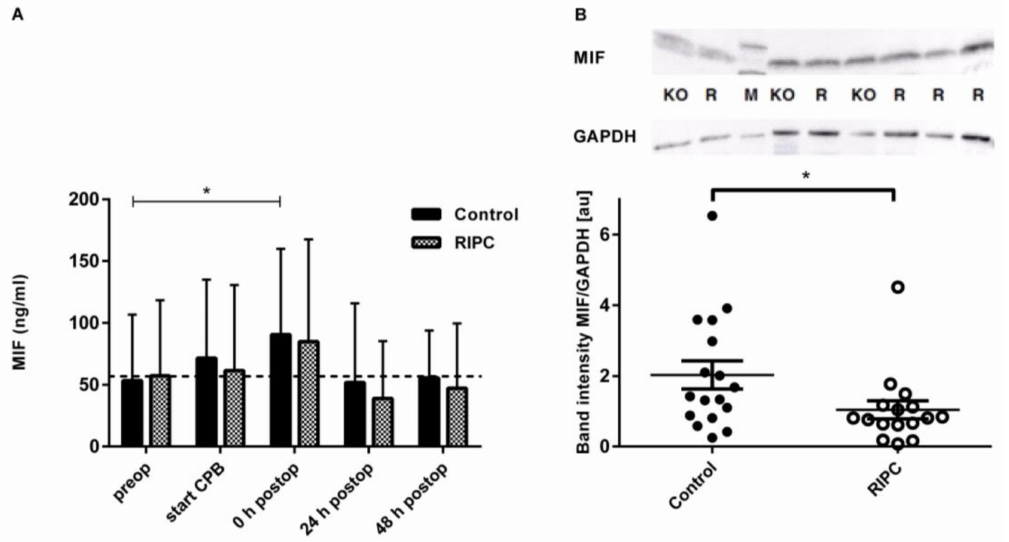
Figure 1. Macrophage migration inhibitory factor (MIF) concentration in serum and heart